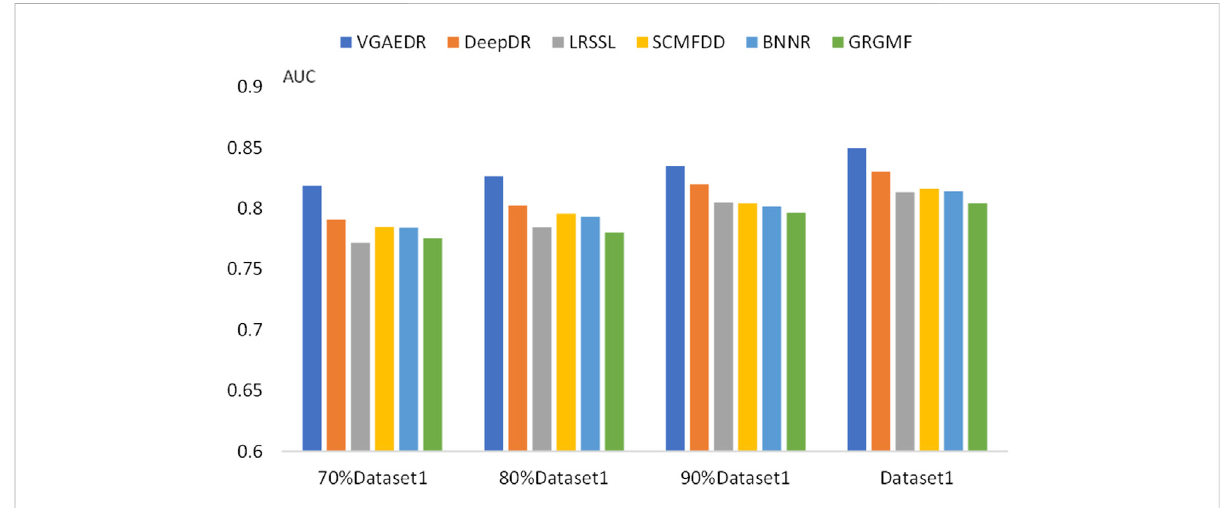
FIGURE 7 AUC of methods based on different fractions of known associations.